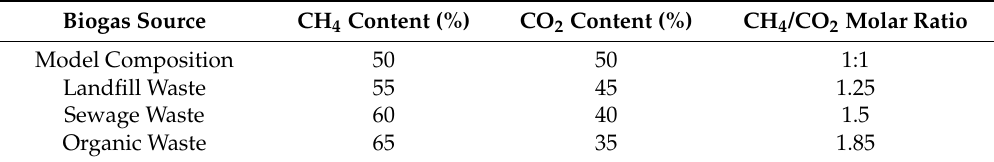
Table 1. List of biogas sources and the corresponding methane and carbon dioxide content, and the resulting CH 4 /CO 2 molar ratio. Adapted from Lau et al.